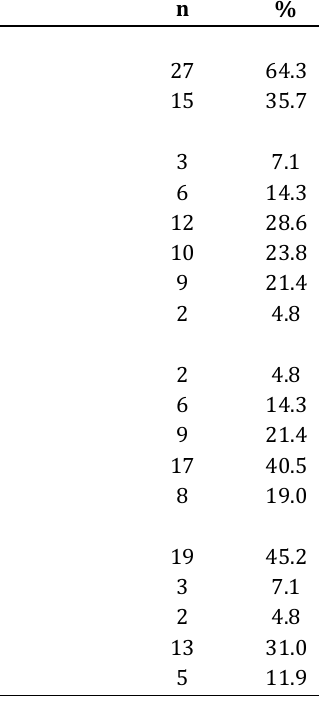
Table 1. The Respondent Characteristic Distribution by Demographic Data (n=42) Demographic